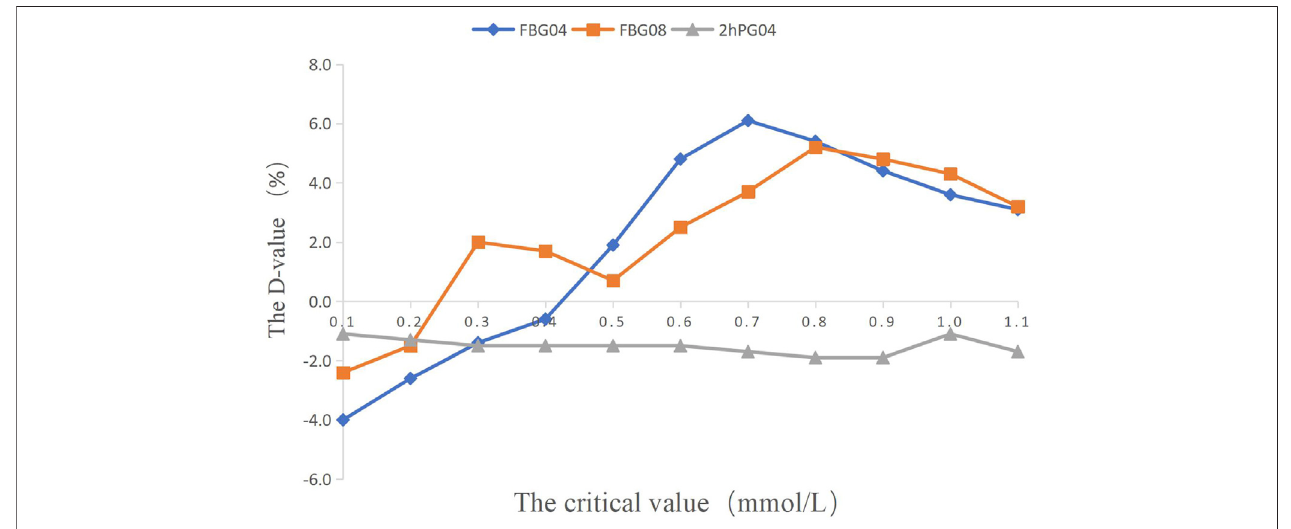
FIGURE 2 | The percentage of ef fi cacy in study 1. The Y-axis represents the Difference value (D-value) between the percentage of ef fi cacy and 85%.